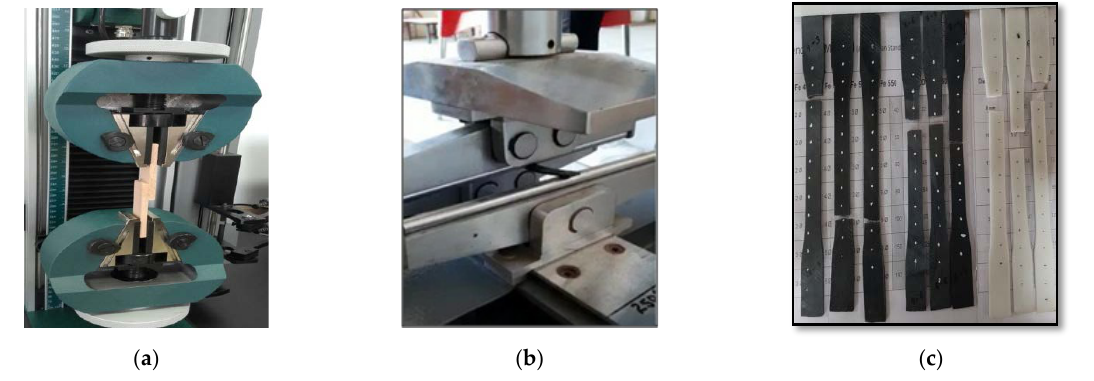
Figure 3. Specimen testing setup for ( a ) tensile test, ( b ) flexural test, and ( c ) tested specimens.